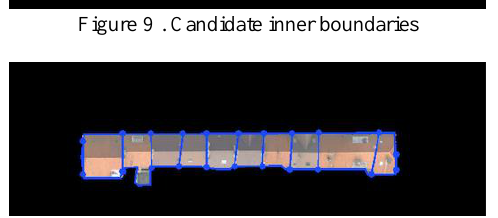
Figure 10 . Building boundaries by eliminating ridge lines